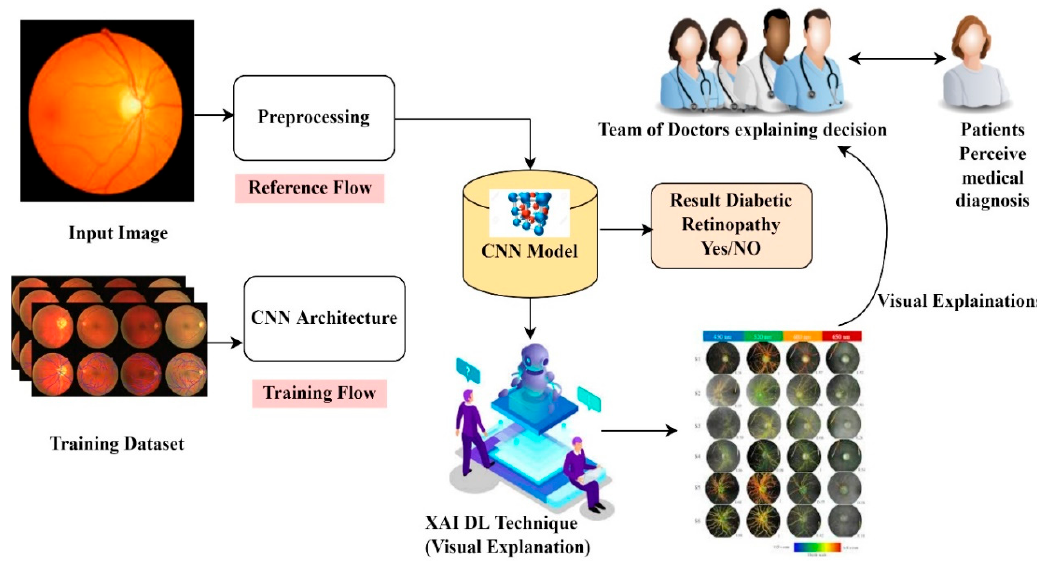
Figure 13. Diabetic retinopathy using XAI.